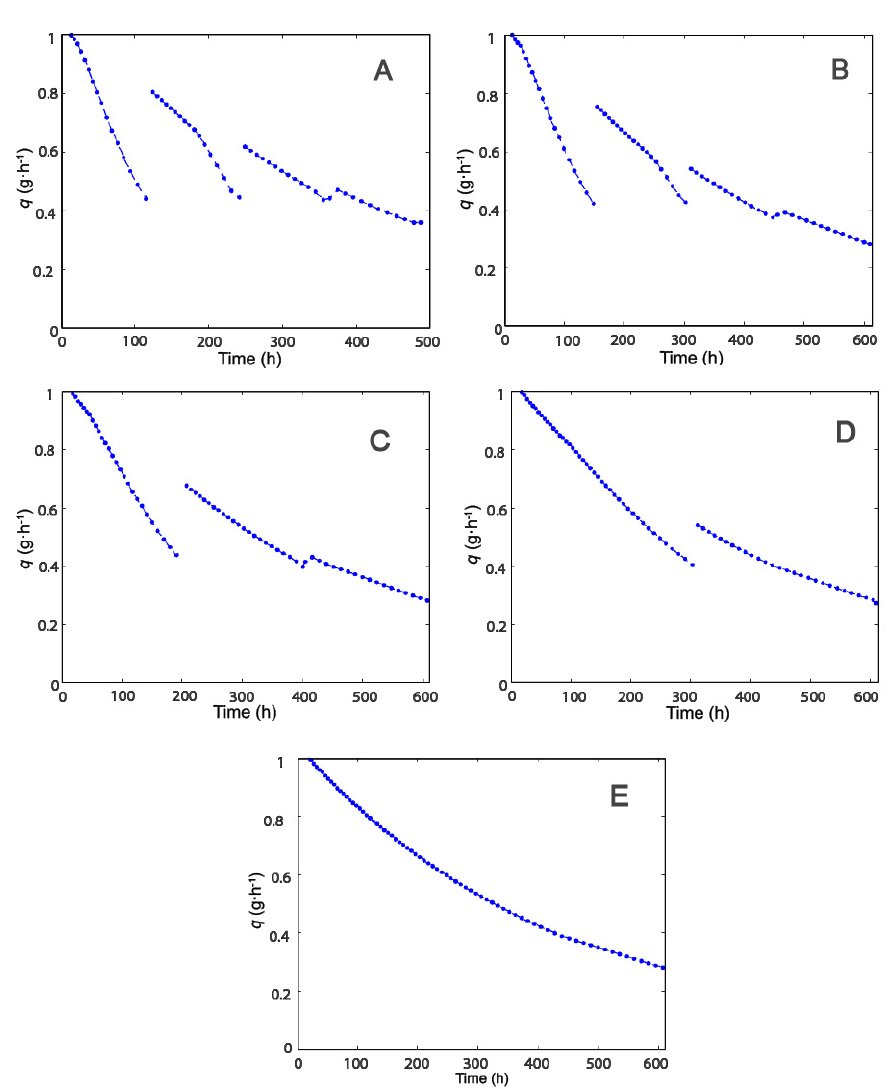
Figure 5. Evolution in productivity in sequential batch operation of lactofructose syrup production in one-pot considering one cycle of use of GI and one or several cycles of use of β -gal. Simulations were performed considering 40 ◦ C, pH 7, 10% ( w / w ) of initial lactose concentration and GI/ β -gal activity ratio of 0.46 (IU GI /IU β -gal ). ( A ) η = 0; ( B ) η = 0.2; ( C ) η = 0.4; ( D ) η = 0.6; ( E ) η =